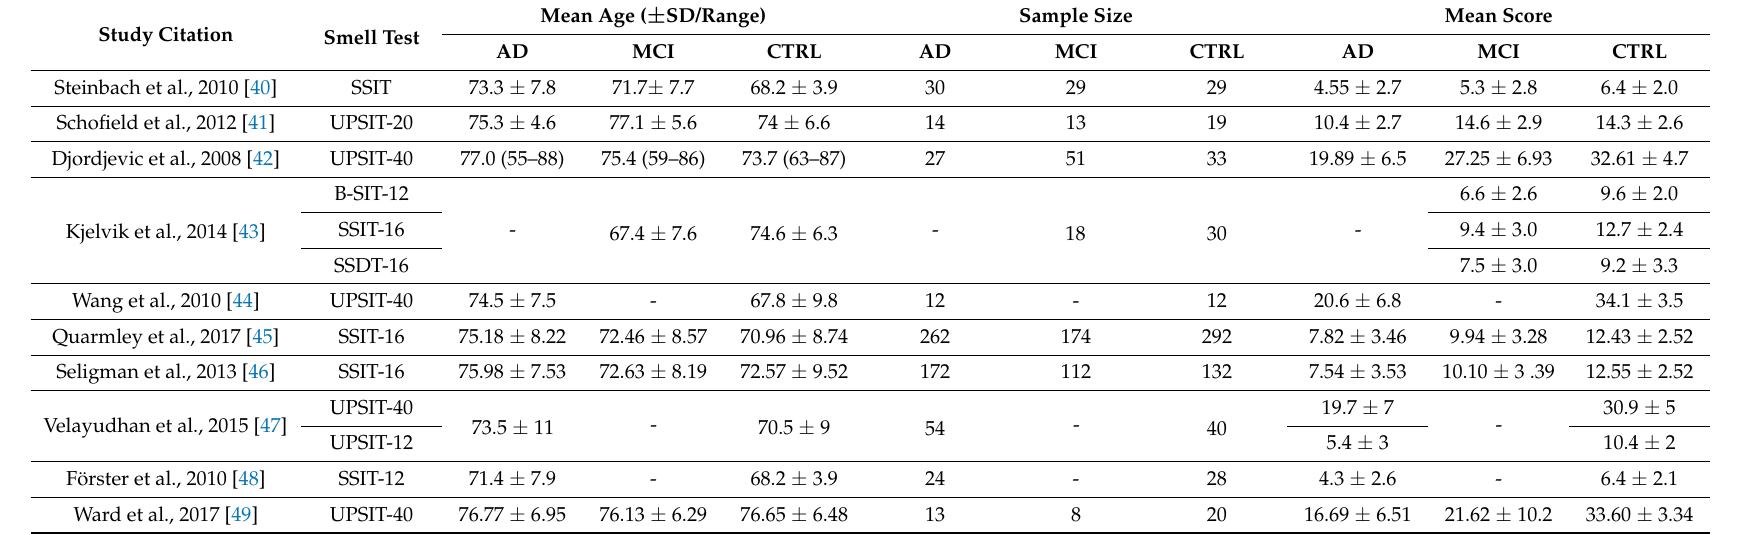
Table 1. Characteristics of the 10 studies included in the